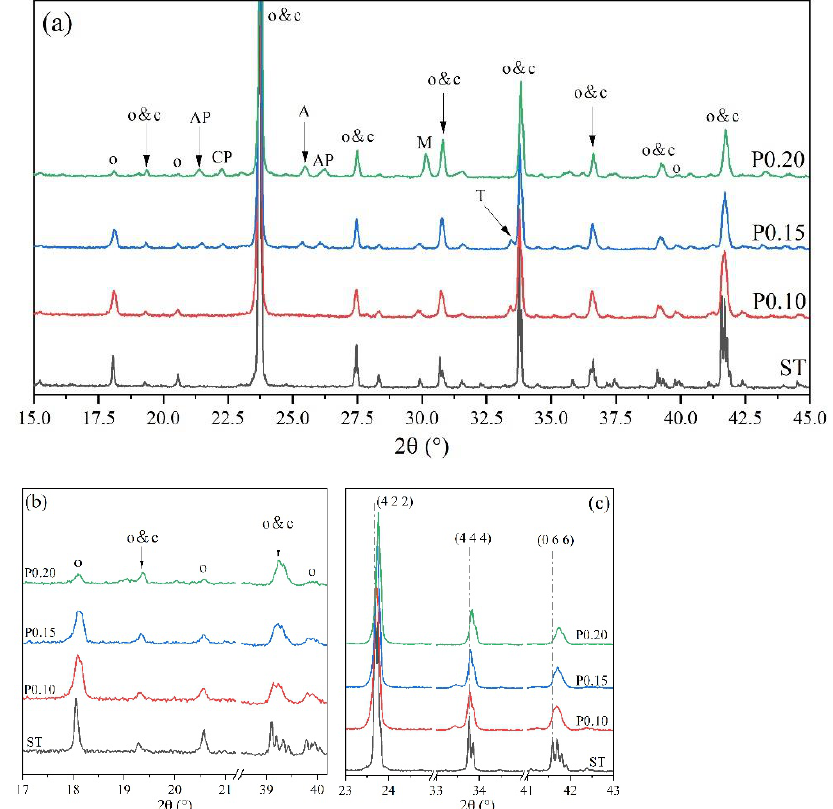
Figure 4. XRD patterns of P-doped ye’elimite, ( a ) identification of phases (o, orthorhombic ye’elimite; c, cubic ye’elimite; A, anhydrite; AP, aluminum phosphate; CP, calcium phosphate; M, monocalcium aluminate; T, tricalcium aluminate), ( b ) comparison of characteristic peaks of orthorhombic ye’elimite, and ( c ) comparison of three major peaks of ye’elimite.